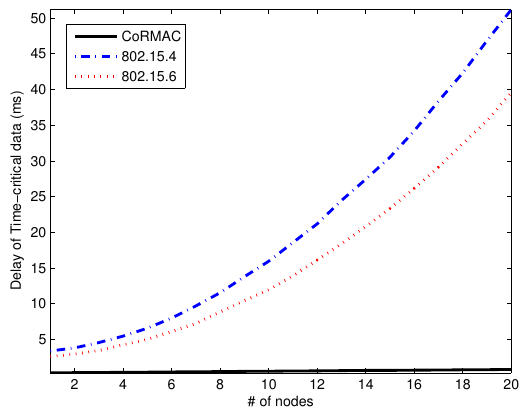
Figure 7. The average delay of time-critical data vs . the number of nodes.